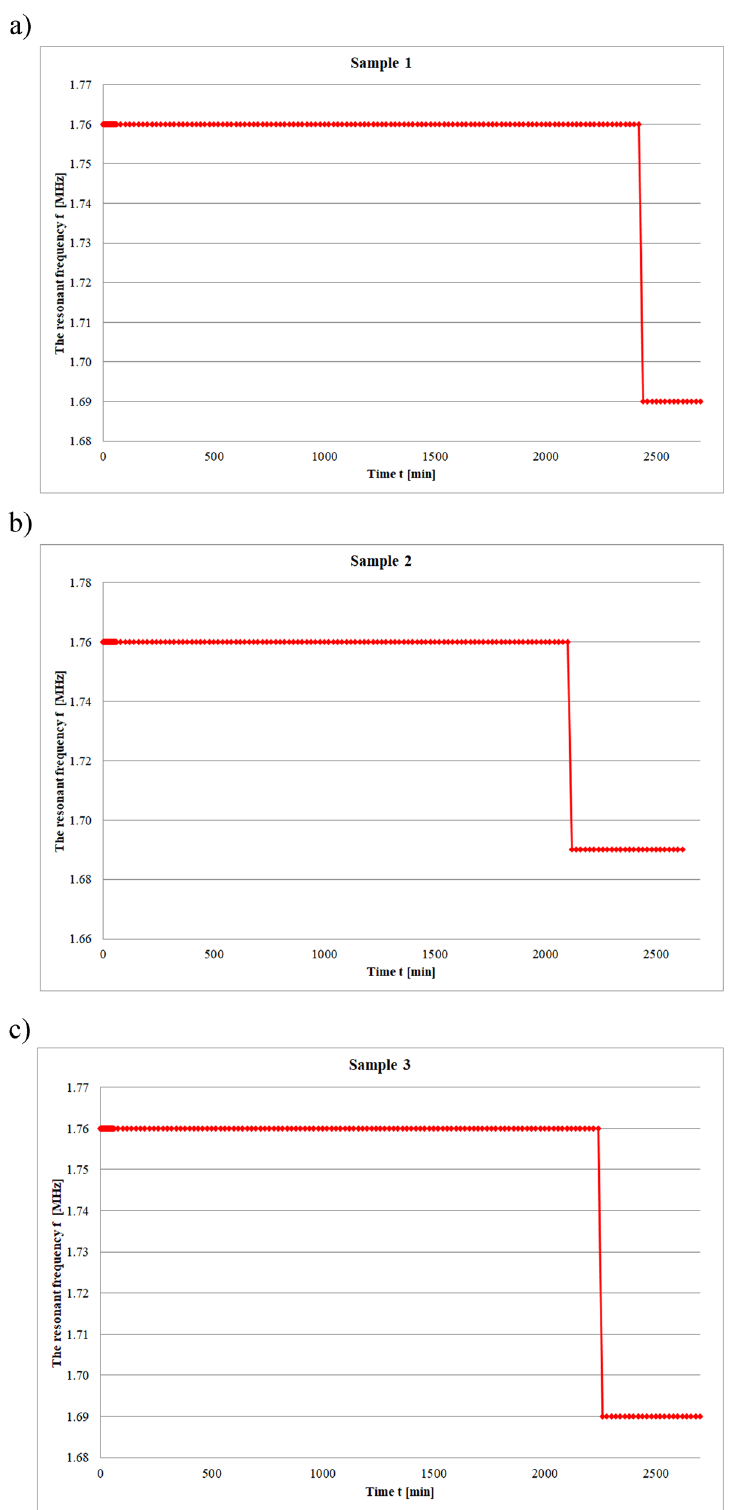
Figure 8: Frequency f of the ultrasonic wave pulse during the process of constitution and degradation of the coating – substrate joint: ( a ) sample 1, ( b ) sample 2 and ( c ) sample